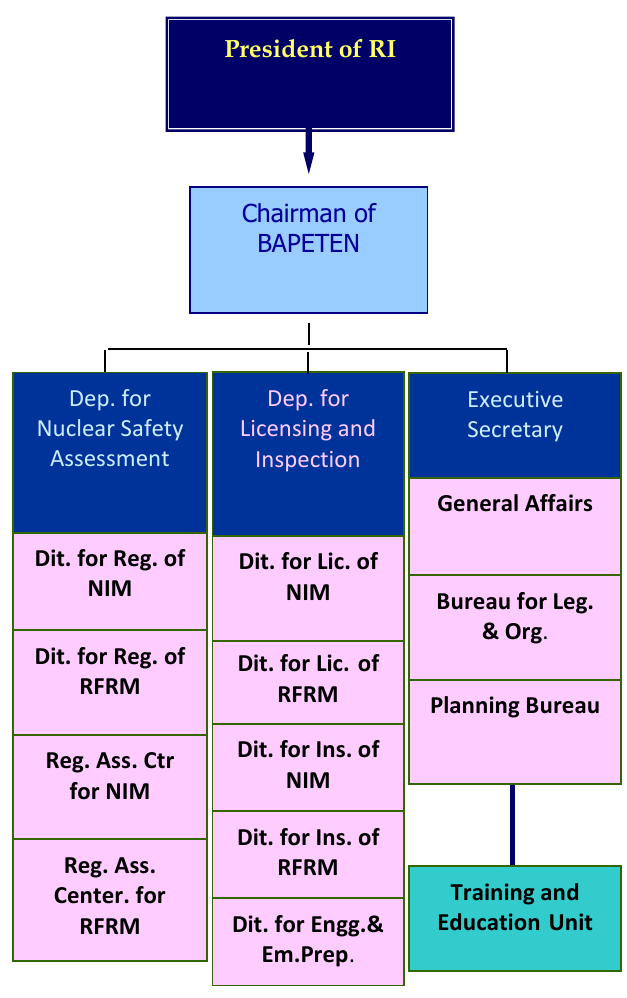
Figure 1. The organization of